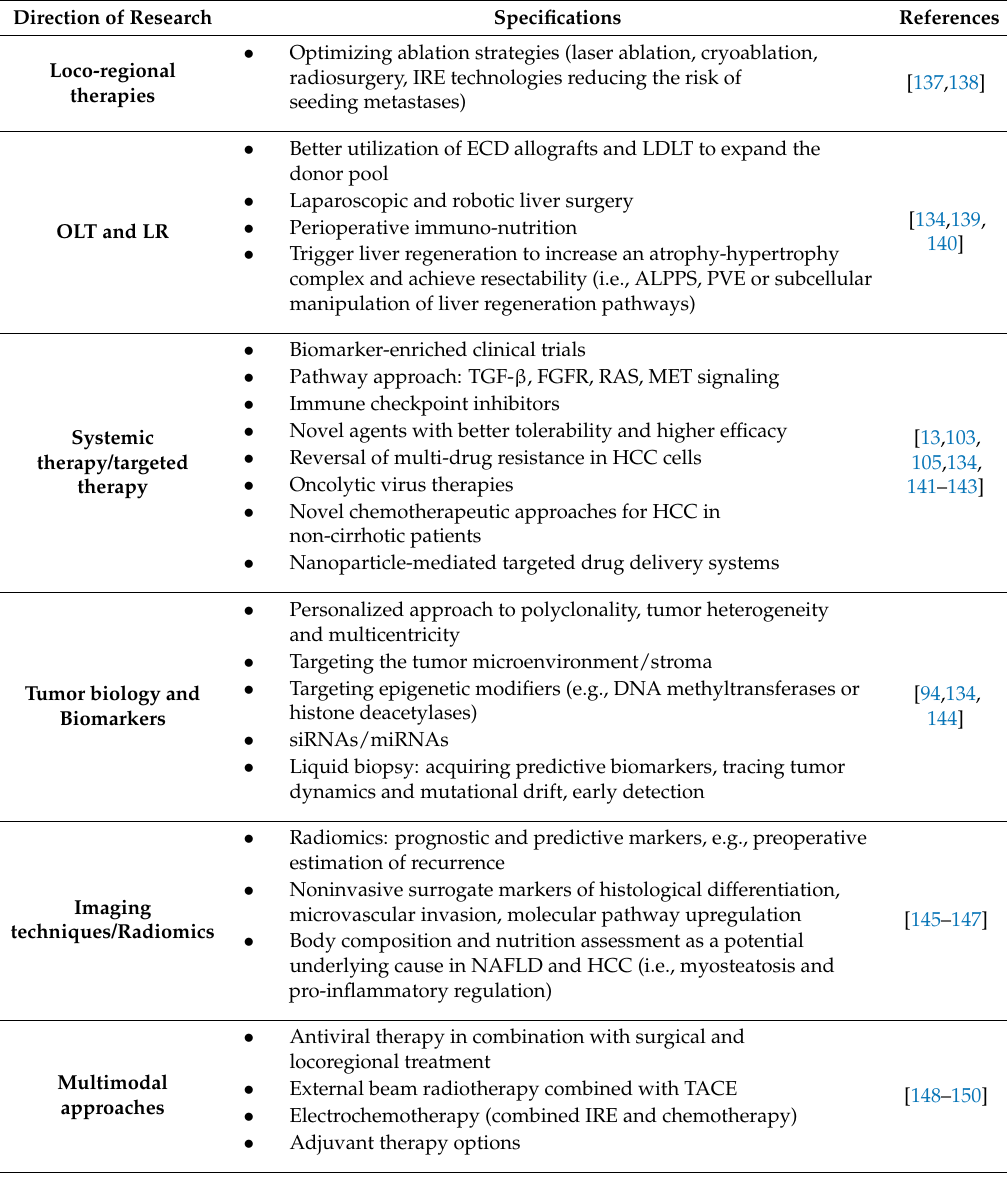
Abbreviations: DNA—deoxyribonucleic acid, FGFR—fibroblast growth factor receptor, MET—mesenchymal-epithelial transition factor, miRNA—micro ribonucleic acid, RAS—Rat sarcoma, siRNA—small interfering ribonucleic acid, TGF- β —Transforming growth factor